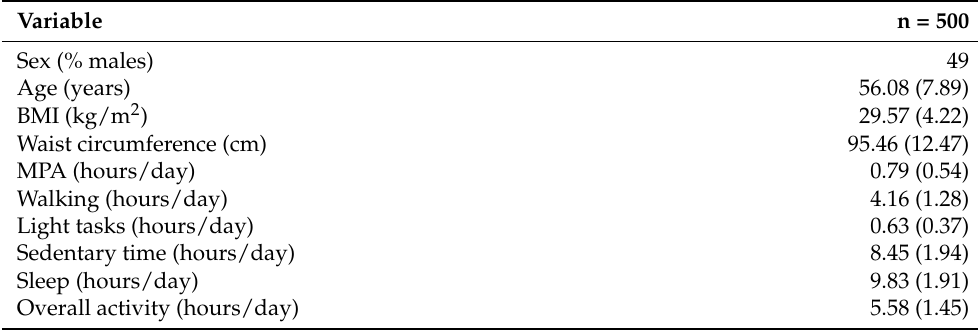
Table 2. Descriptive characteristics of the sample used in the analyses: the mean values and standard deviations (in brackets). BMI: body mass index, MPA: moderate physical